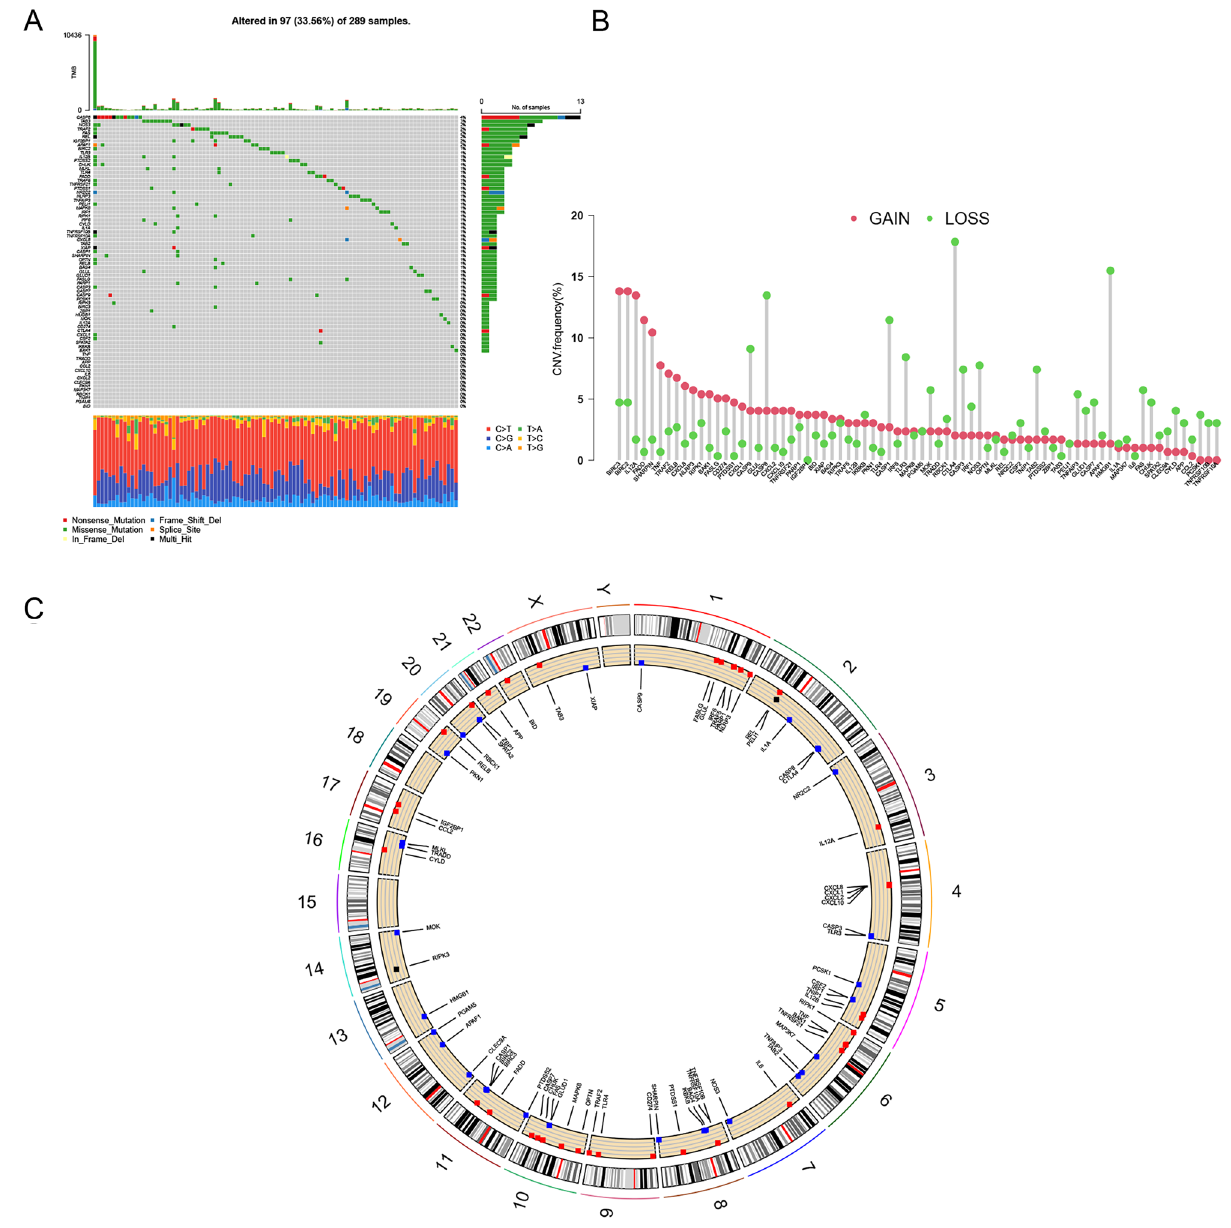
( B ) CNV of 74 NRmRNAs: Columns: CNV frequency; Red dots: CNV amplification; Green dots: deletion of CNV. ( C ) Location of CNV alterations in the intracellular NRmRNAs: Red: high frequency of increased NRmRNAs copy number; Blue: high frequency of deleted NRmRNAs copy